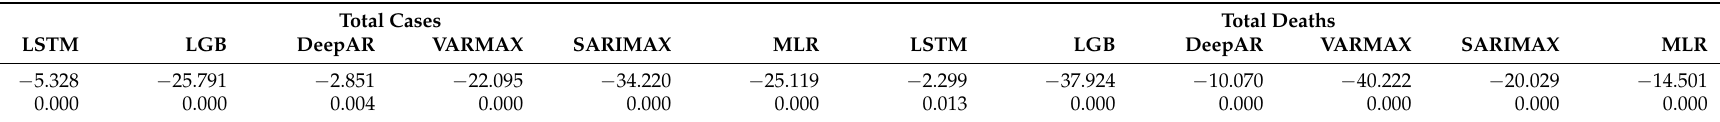
Table 14. Student’s t-test for Prediction Interval MIS (H 0 : Benchmark Prediction Intervals Outperform MES-LSTM).